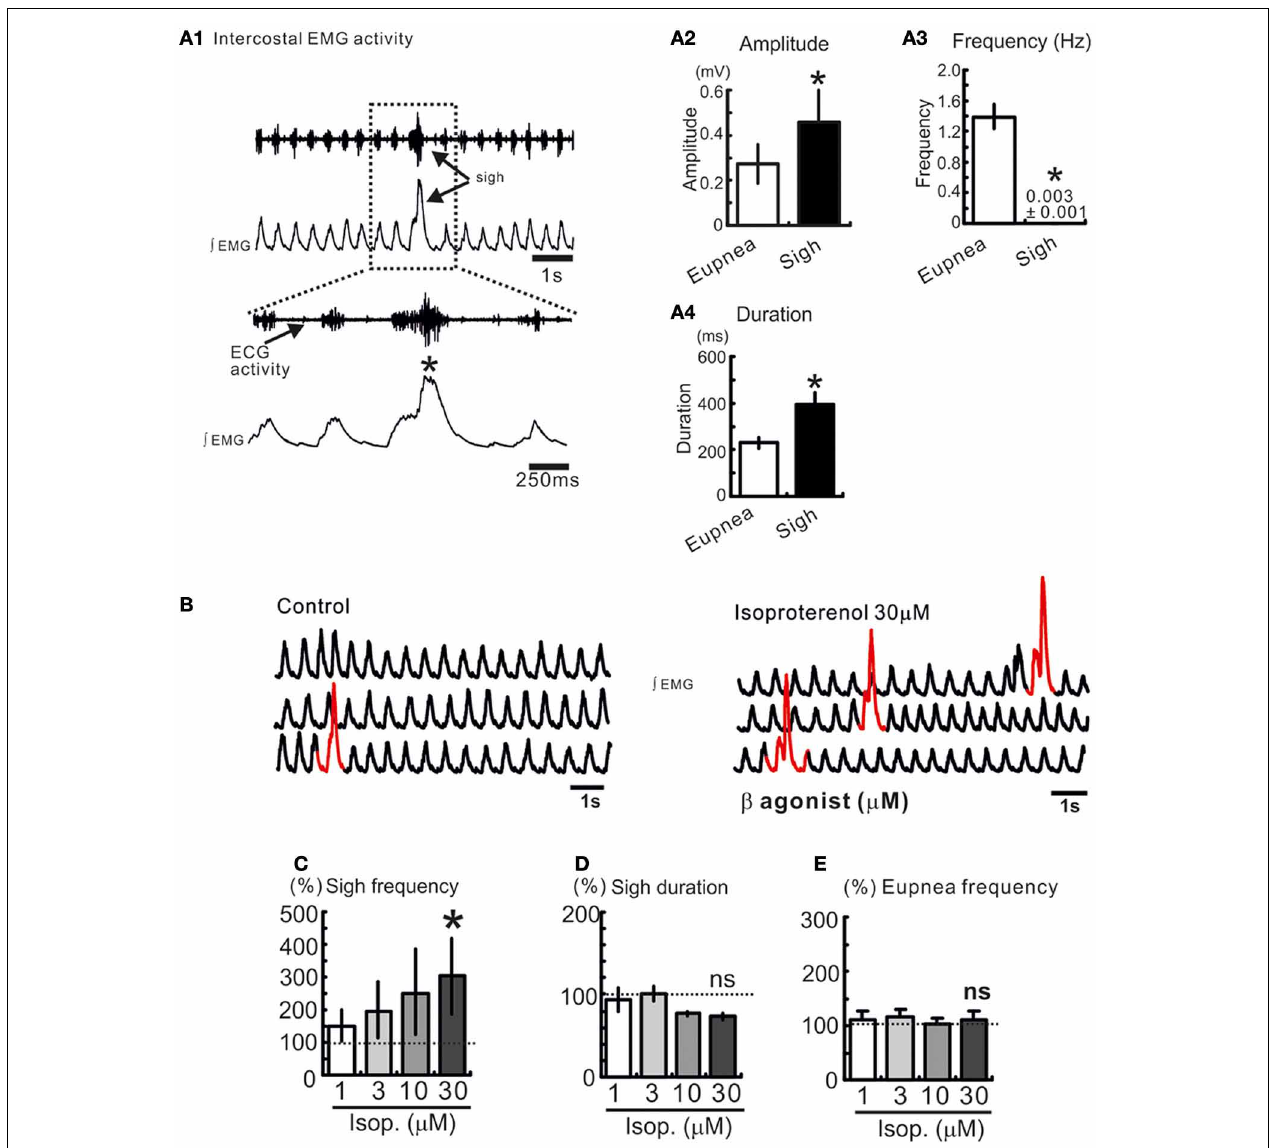
FIGURE 1 | Sighs are spontaneously generated in freely breathing mouse preparation. (A1) Intercostal EMG activity recording in an anesthetized freely breathing mouse. Sigh is generally triggered and preceded by an inspiratory burst of fictive eupneic activity. Histograms summarize the differences between spontaneous sighs and fictive respiratory activity, in